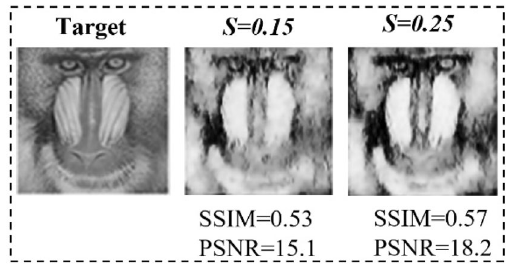
Figure 9. Results for experiment-2 on ‘mandrill’ test set image (as unseen target).